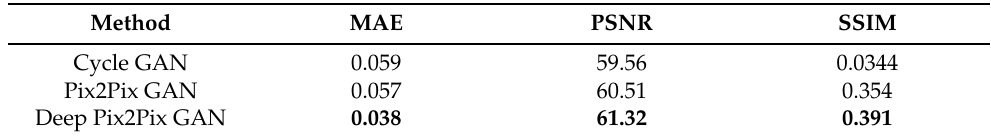
Table 1. The results of the three models in Brain slices images dataset using MAE, PSNR and SSIM as